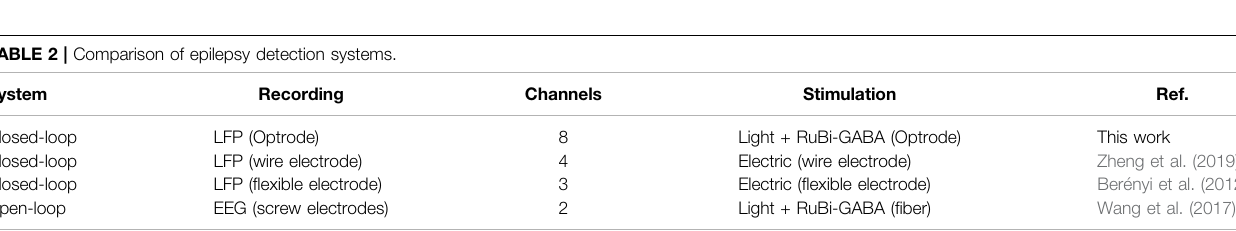
TABLE 2 | Comparison of epilepsy detection